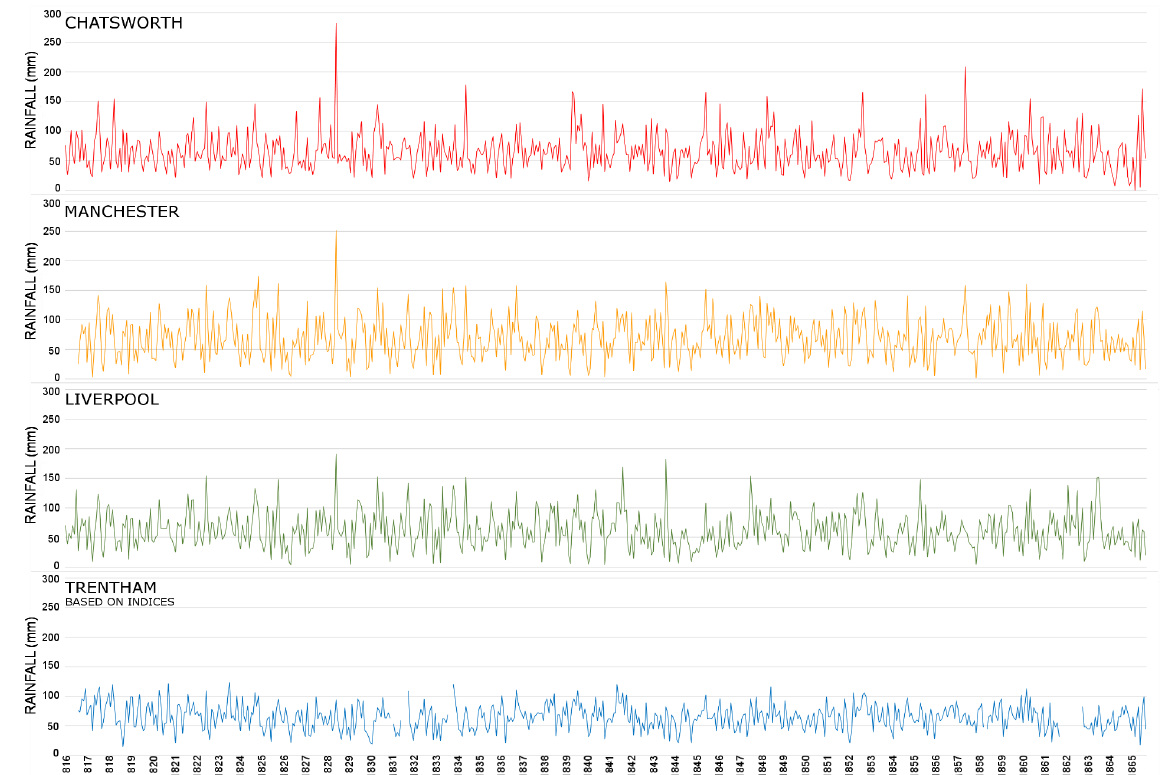
Figure 8. Rainfall (in mm) at Chatsworth (red), Manchester (yellow), and Liverpool (green) and an estimate of the rainfall (in mm) at Trentham (blue) based on the index